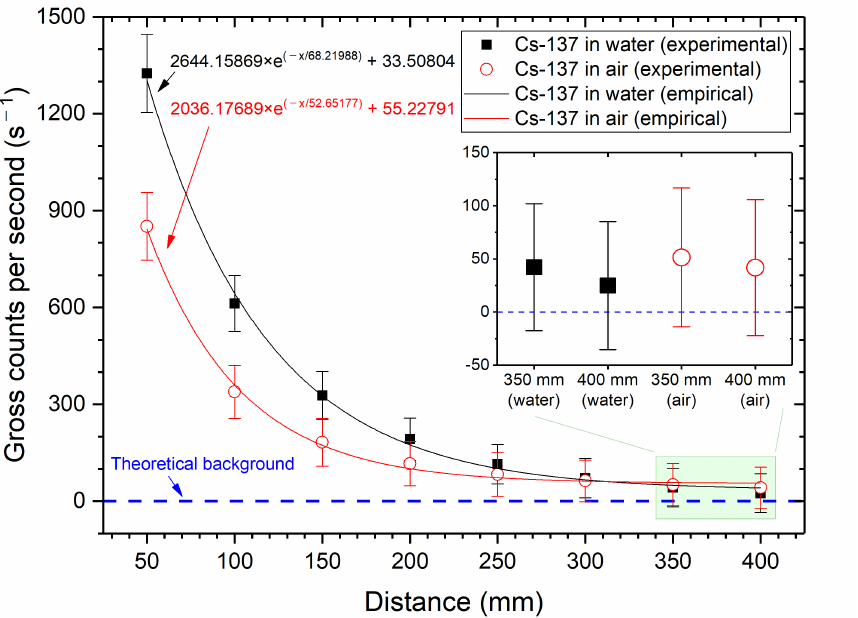
Figure 7. Gross counts per second of Cs-137 as a function of the distance.